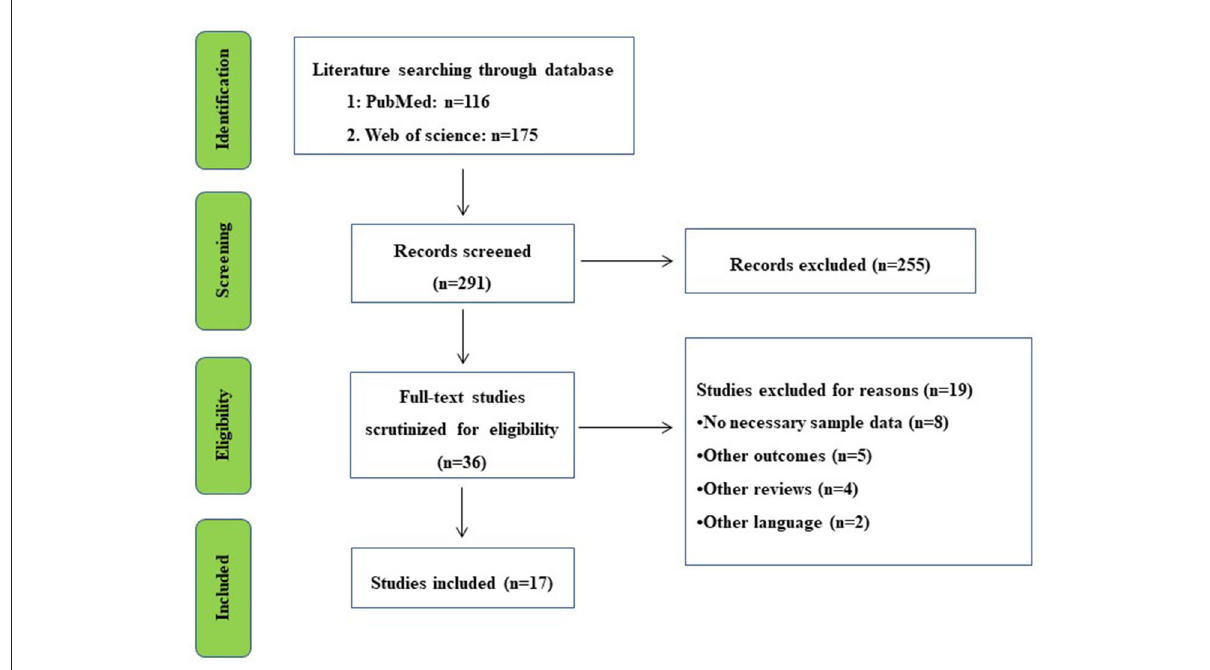
FIGURE1 Literature review